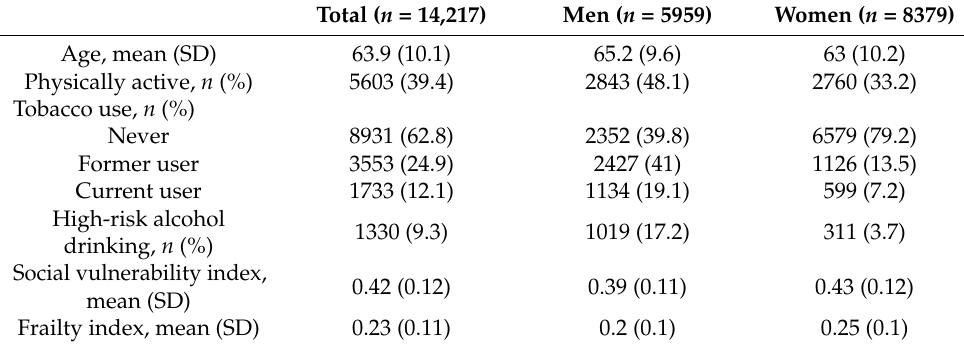
Table 1. Baseline characteristics of participants stratified by